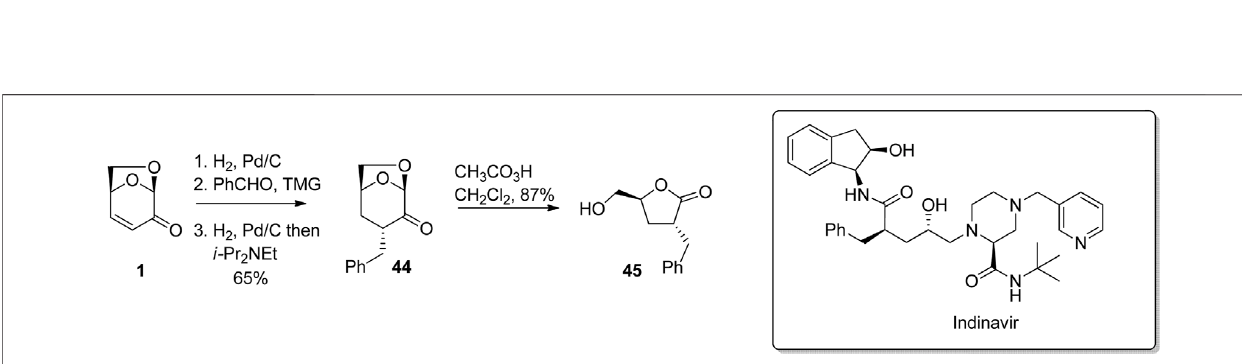
FIGURE 13 | Conversion of LGO into protected ribonolactone derivatives used to synthesise antiviral compounds.